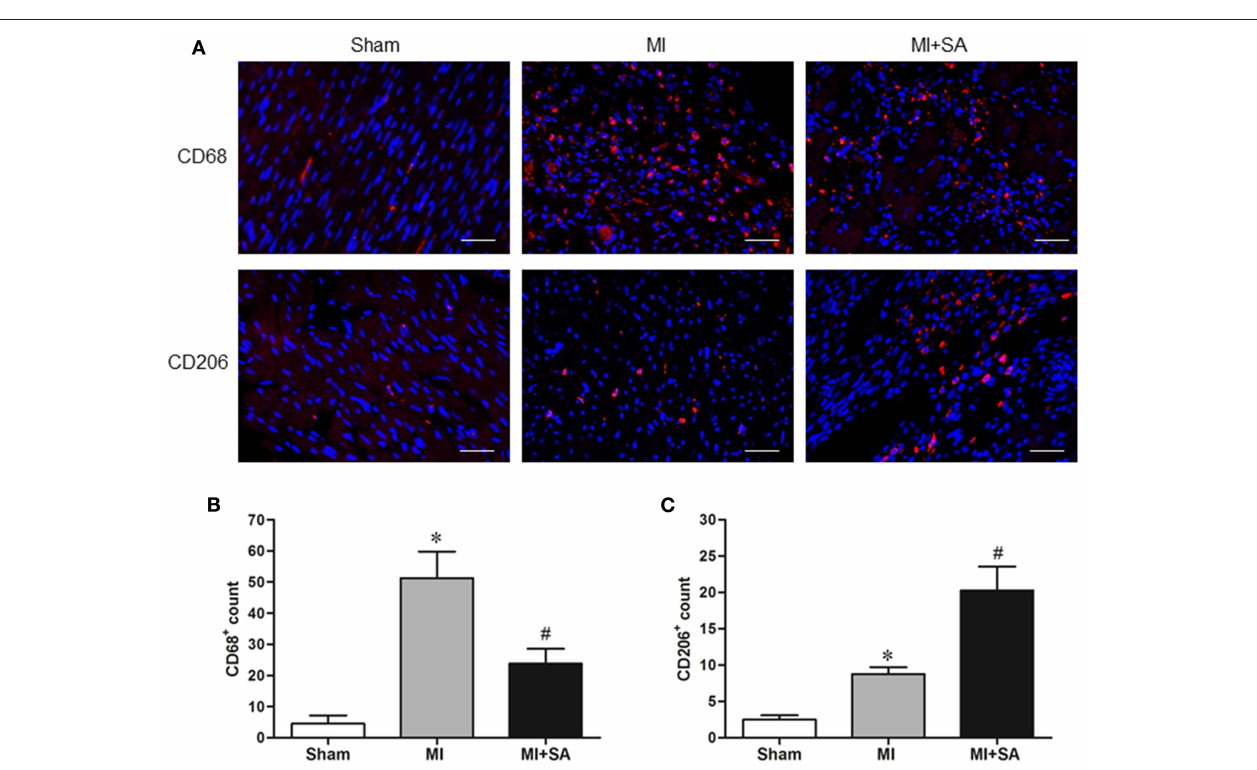
FIGURE 4 | SA decreased CD68-positive macrophage infiltration and induced M2 macrophage polarization at 1 week after MI. (A) The general macrophage marker CD68 and the M2 macrophage marker CD206 were detected by immunostaining analysis. Positive staining of CD68 and CD206 is red. The nuclei were counterstained with DAPI (blue). Scale bar, 100 µ m. (B,C) Immunostaining quantitative analysis showed that CD68 expression was decreased and CD206 expression was increased after SA treatment. *Compared with the sham group, P < 0.05, # Compared with the MI group, P < 0.05, n = 8 in each group.